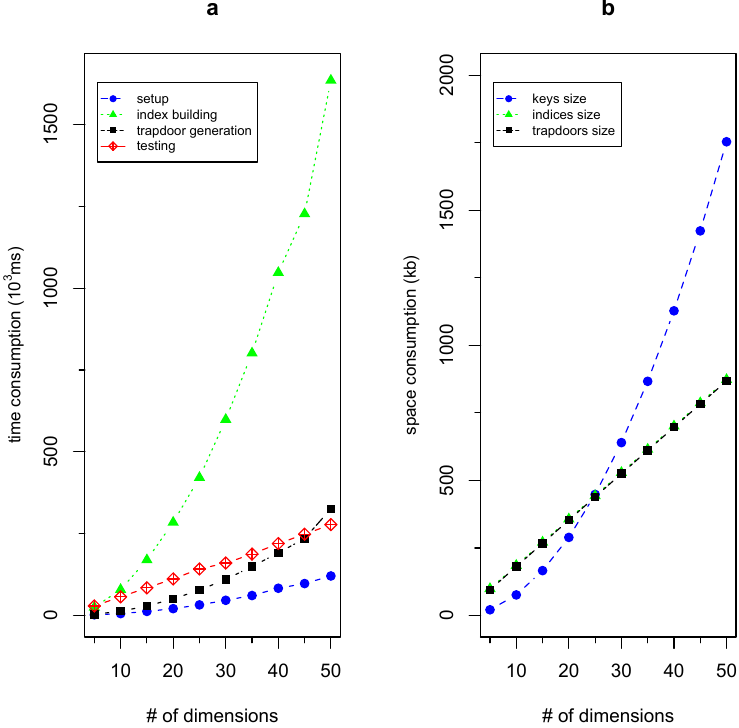
Figure 2. Impact of N on the time cost of key generation, index construction, trapdoor generation and testing in PEDK-0 and PECDK ( a ); and impact of N on the storage cost of the size of keys, indices and trapdoors in PEDK-0 and PECDK ( b ). ( D = 100, N = { 5,10,15,20,25 }